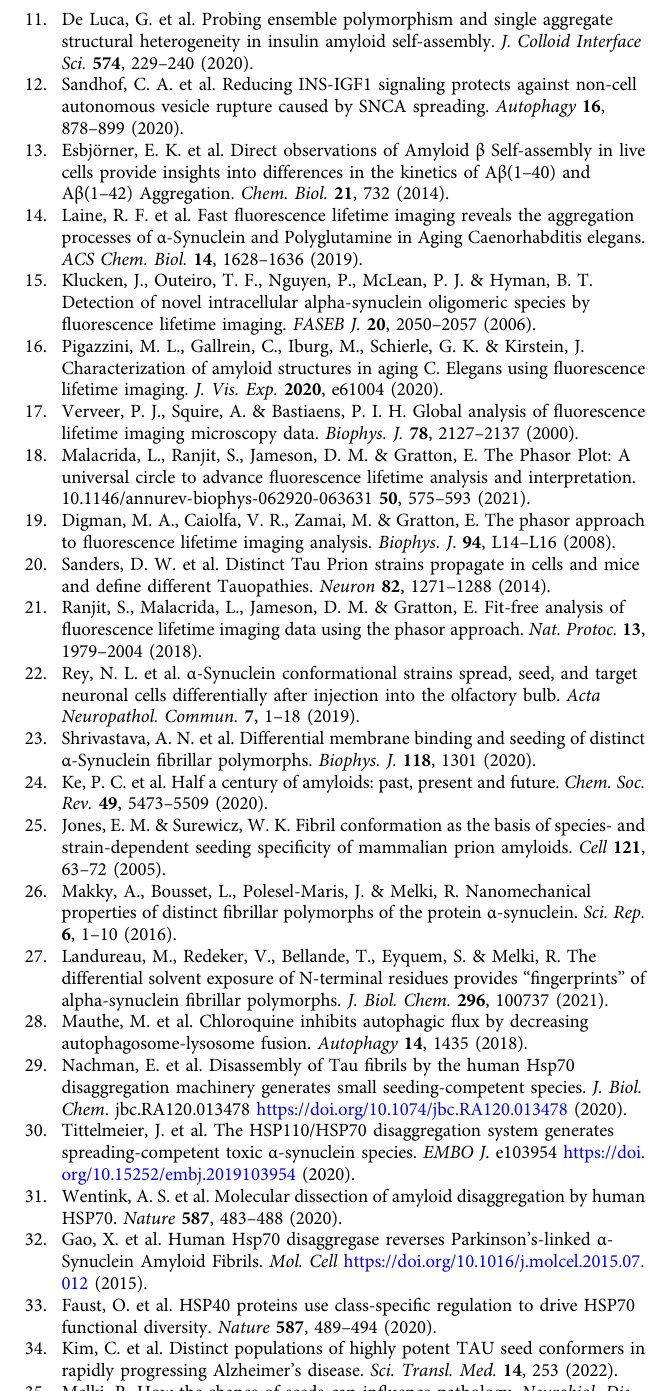
Fig. 6 Differential processing of α -Syn polymorphs by the protein clearance pathways. Phasor plots of the fl uorescence lifetime of F65-Atto647 and F91- Atto647 seeds upon cells treatment with chloroquine (CQ) ( a ), MG132 ( d ), or DNAJB1 siRNA ( g ). Histograms of F65-Atto647 and F91-Atto647 showing the relative abundance (rel. abundance) of pixels with a certain fl uorescence lifetime (ranging from 0 to 1.8 ns), averaged over all acquired images ( n = 15 for each condition, mean ± SEM). b , e , h The mean fl uorescence lifetime ( τ ) of F65-Atto647 and F91-Atto647 upon indicated treatment. Data are shown as mean ± SEM. Statistical analysis was done using unpaired t -test (for F65 b , h , F91 b , e , f ) or Mann-Whitney test (for F65 e ). Quanti fi cation of cells with visible foci ( n = 30, mean ± SEM). Statistical analysis was done using a Mann-Whitney test (for F65 c , F91 c , f , i ) or an unpaired t -test (for F65 f , i ). Inhibition of autophagy ( c ) and the proteasome ( f ), and silencing of the HSP110/HSP70 disaggregation machinery by DNAJB1 siRNA ( i ) partially blocks the processing of F65-Atto647 seeds, which reduces α -Syn seeding. In contrast, only inhibition of autophagy partially blocks the processing of F91- Atto647